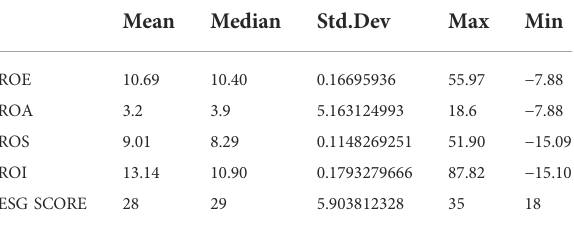
TABLE 4 Summary of the most important fi gures regarding fi nancial and social concerns. Source: Own elaboration.